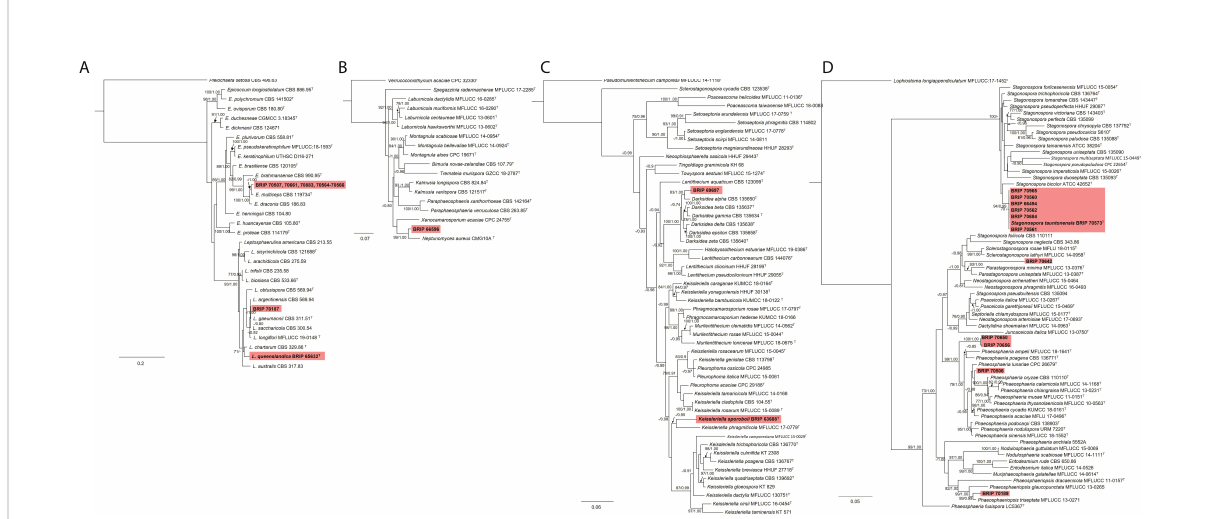
FIGURE 10 Phylogenetic trees inferred from RAxML analyses of strains in Pleosporales based on concatenated alignments of (A) ITS and rpb2 sequences of related genera from Didymellaceae; (B) ITS, LSU, SSU and tub2 sequences of related genera from Didymosphaeriaceae; (C) ITS, LSU and tef1 - a sequences of related genera from Lentitheciaceae; and (D) ITS, LSU, SSU and tef1- a sequences of related genera from Phaeosphaeriaceae. RAxML bootstrap (bs) values greater than 70% and Bayesian posterior probabilities (pp) greater than 0.8 are given at the nodes (bs/pp). In bold font are the isolates from this study, and ex-type strains are indicated with T